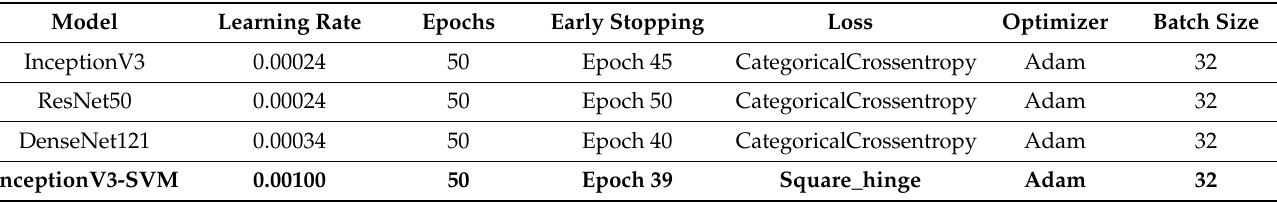
Table 4. Parameters Used for model training.